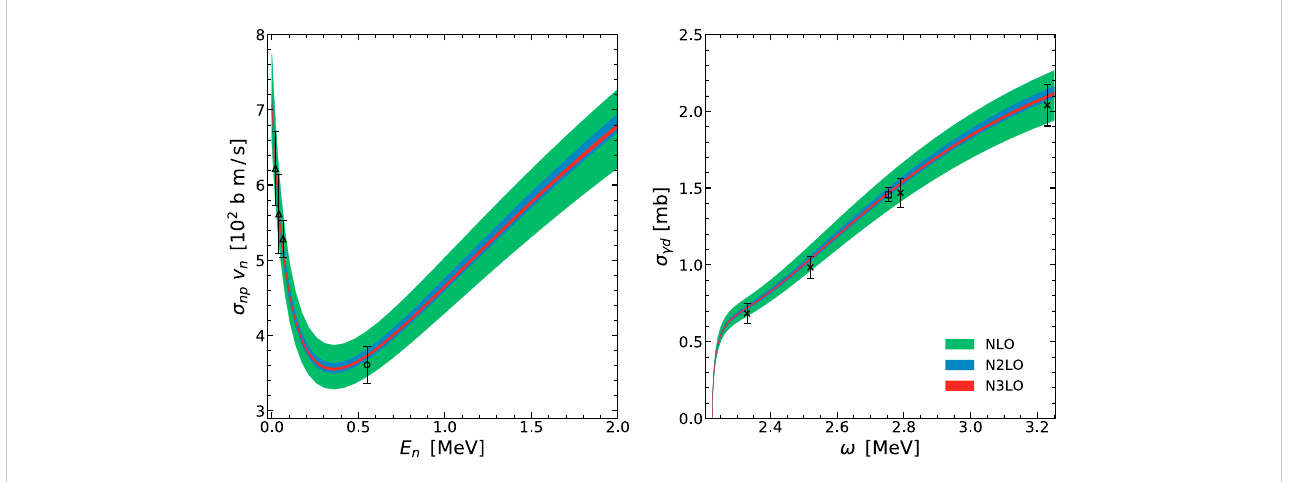
FIGURE 3 The product of p ( n , γ ) d cross section σ np and the neutron speed v n versus the neutron energy E n (left panel); and the deuteron photodissociation cross section σ γ d as a function of the photon energy ω in the rest frame of the deuteron (right panel). The bands indicate 95% Bayesian degree-of-belief intervals at the various orders. Experimental data are from Ref. [40] (triangles) [41] (circle) [42] (crosses) and [43] (square). Experimental errors in beam-energy resolution are not shown.